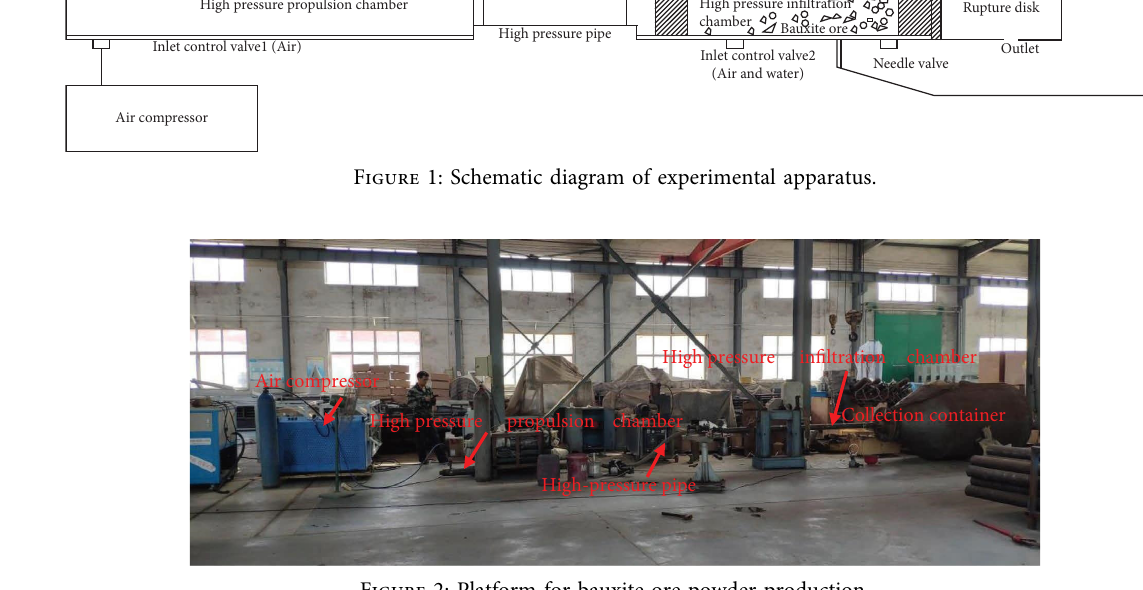
Figure 2: Platform for bauxite ore powder production.